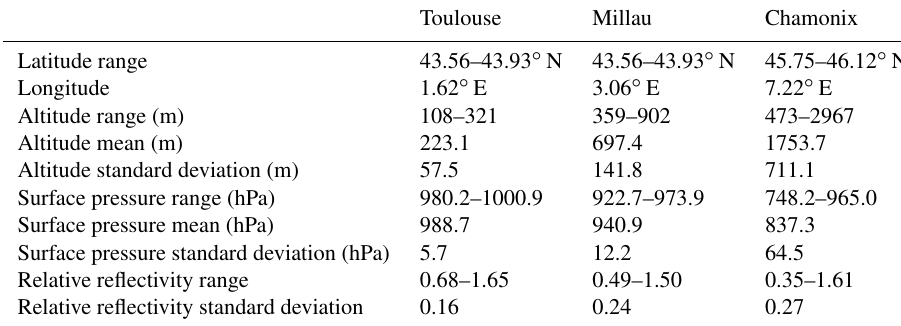
Table 4. Characteristics of the data used for the simulation.